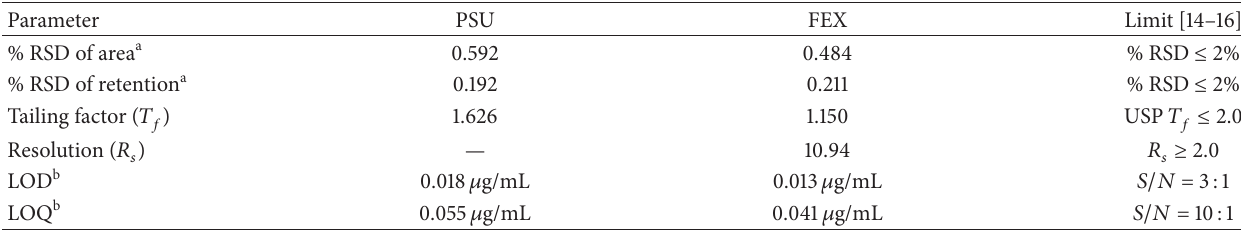
Table 8: System suitability study.